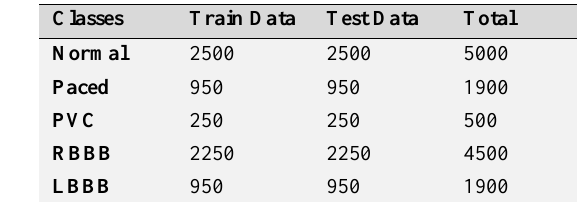
Table 1. Number of used ECG